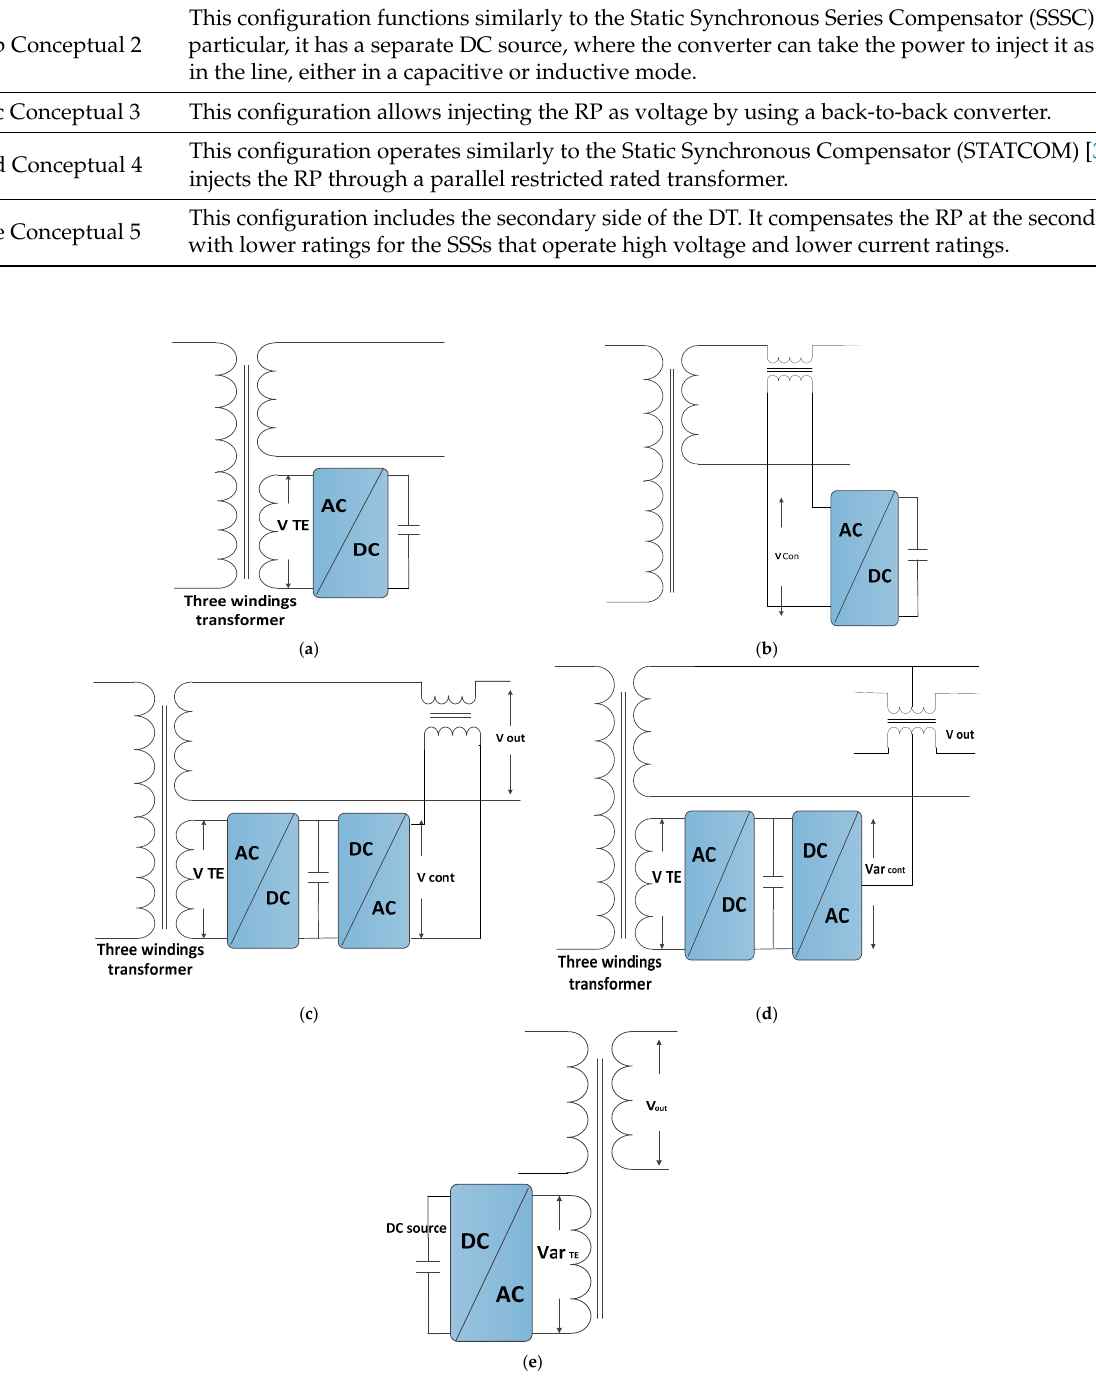
Figure 3. ( a ) Conceptual 1, a converter attached separately to tertiary winding; ( b ) Conceptual 2 with a converter supporting the secondary side ; ( c ) Conceptual 3, back-to-back converter supporting the secondary sides in series mode; ( d ) Conceptual 4, back-to-back converter supporting the secondary sides in parallel mode; ( e ) Conceptual 5, a converter attached to the primary side.